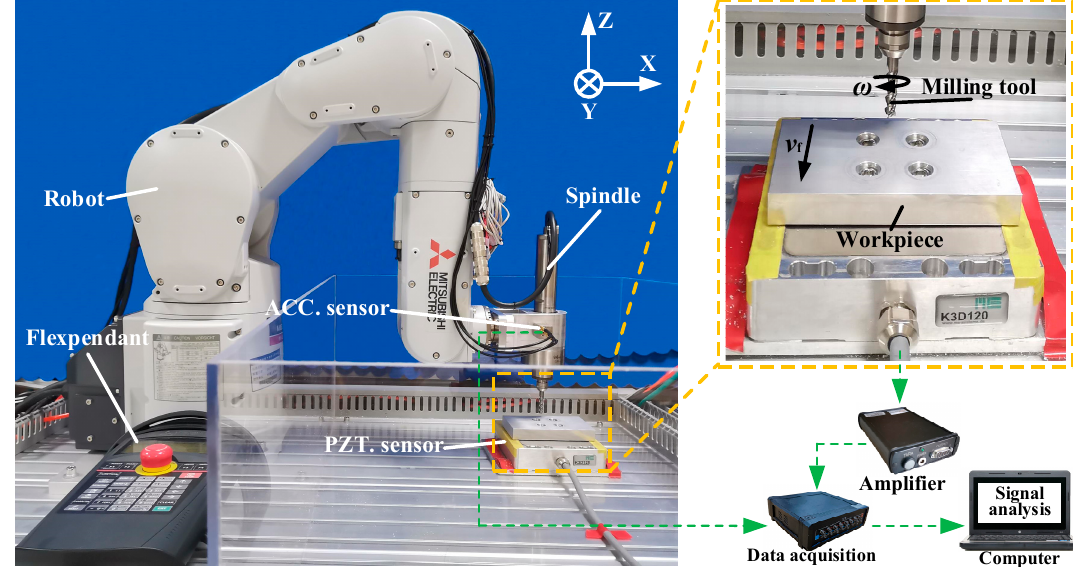
Figure 1. Schematic diagram of the experimental setup. Table 1. Chemical composition of 7075-T651.